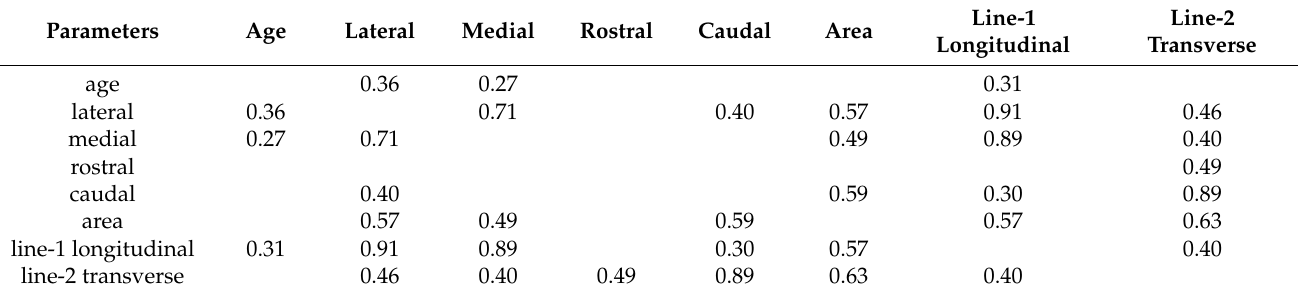
Table 3. The r-value for the female group correlations ( r -value presented only for pairs showing statistically significant correlation, p ≤ 0.05).